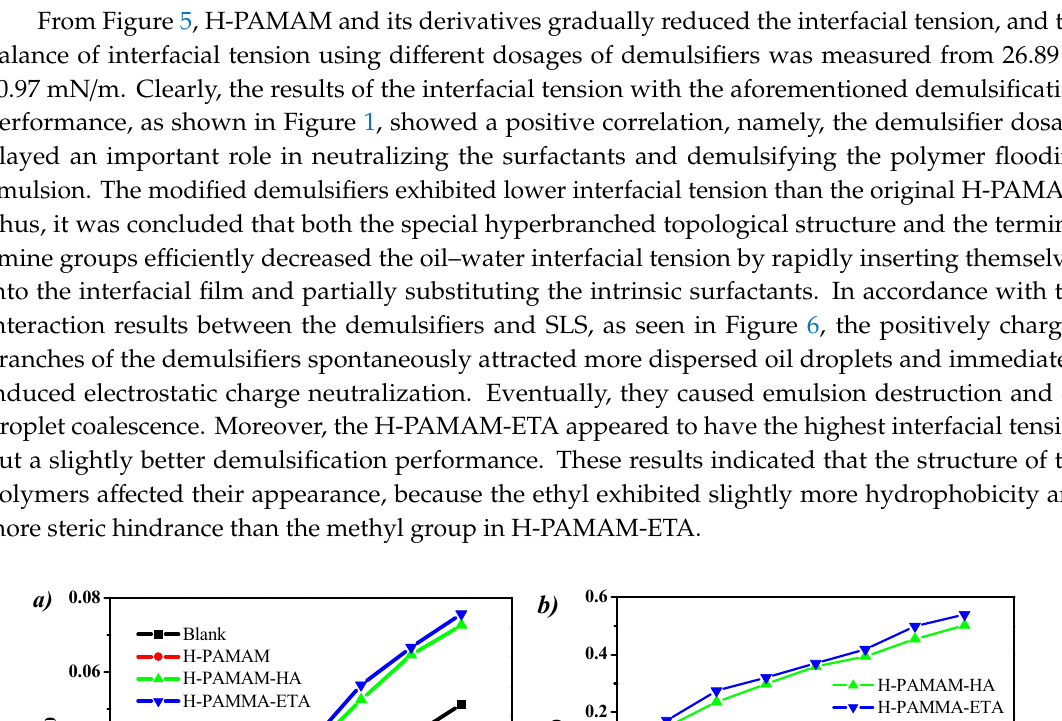
Figure 5. The interfacial tension versus the dosages of the demulsifiers at room temperature.